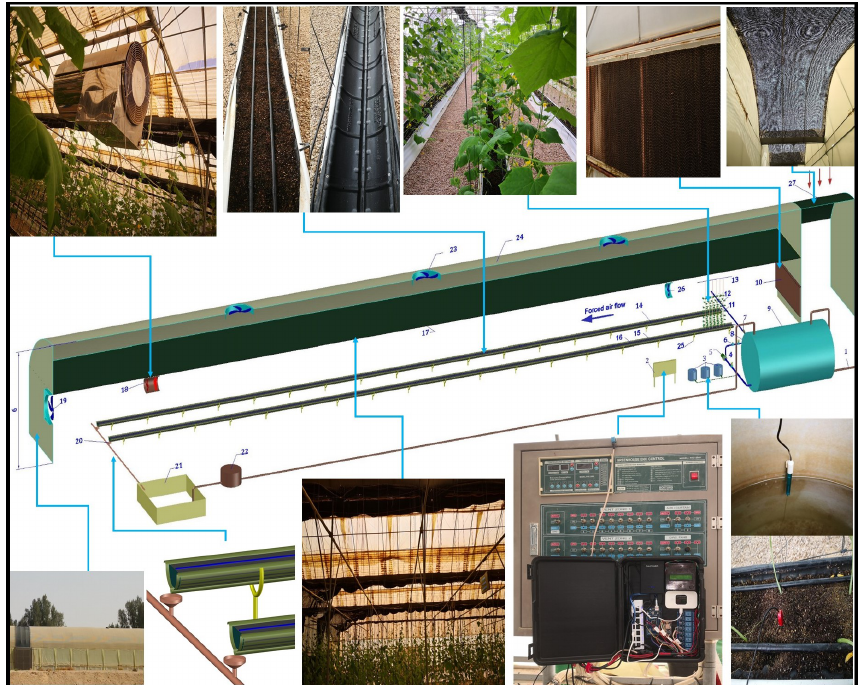
Figure 2. An interior view for a cultivation line in the greenhouse with different irrigation, drainage, and control systems,